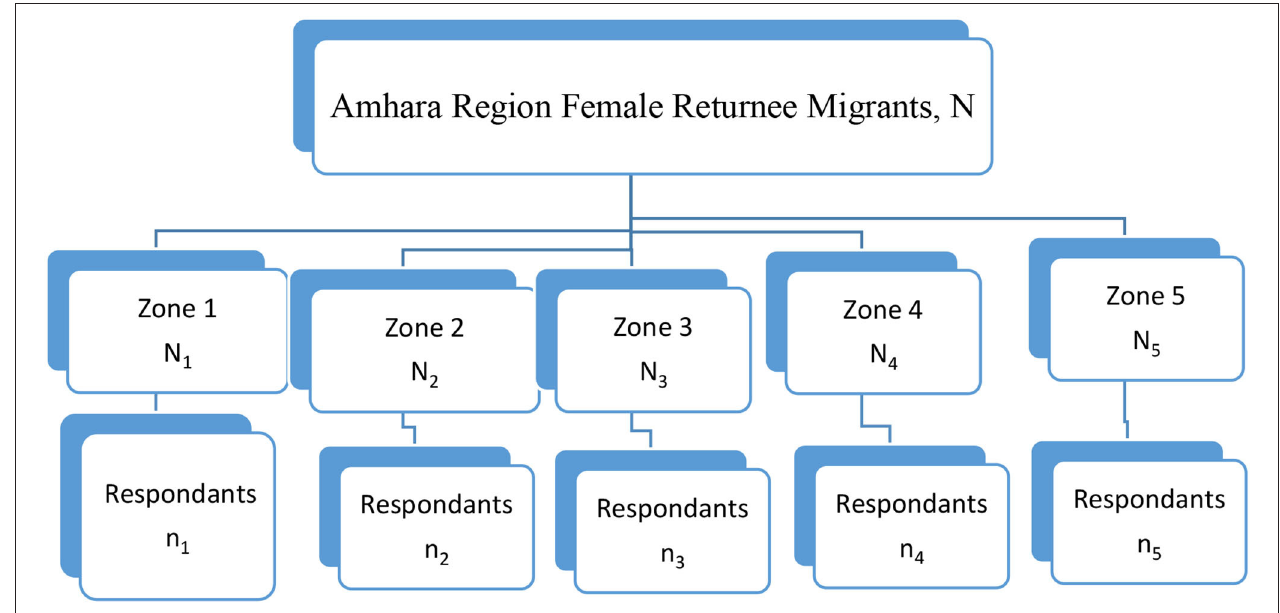
FIGURE 1 | Sampling schema.